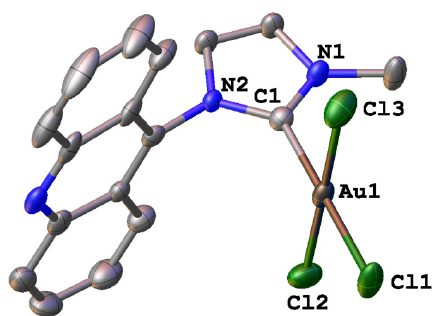
Figure 3. Solid structure of complex 1 with 50% probability ellipsoids. Hydrogen atoms and dichloromethane molecules are omitted for clarity. Selected bond lengths (Å) and angles ( ◦ ): Au(1)-C(1) 2.007(6), Cl(2)-Au(1)-Cl(1) 91.41(7), Cl(3)-Au(1)-Cl(1) 90.93(7), C(1)-Au(1)-Cl(2) 89.52(17), C(1)-Au(1)-Cl(3) 88.15(17).